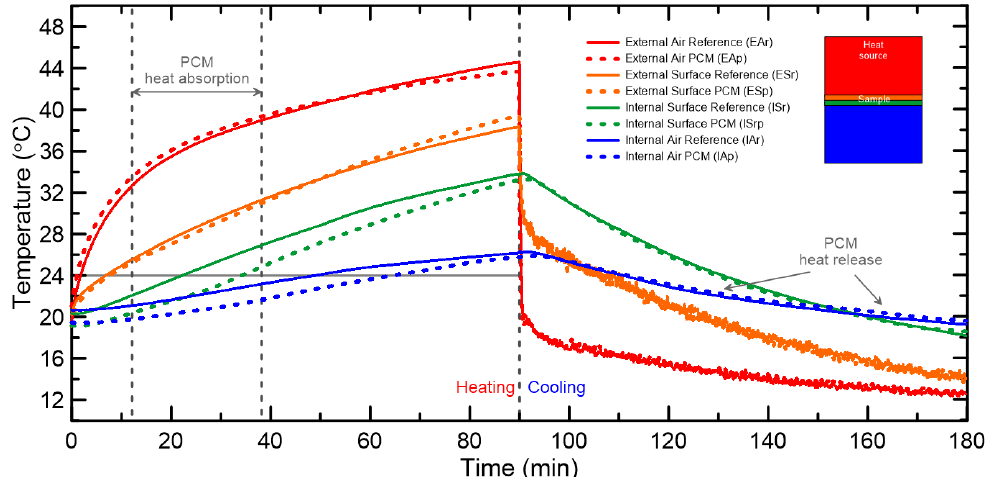
Figure 15. Temperature profiles of studied composites submitted to thermal tests during heating and cooling